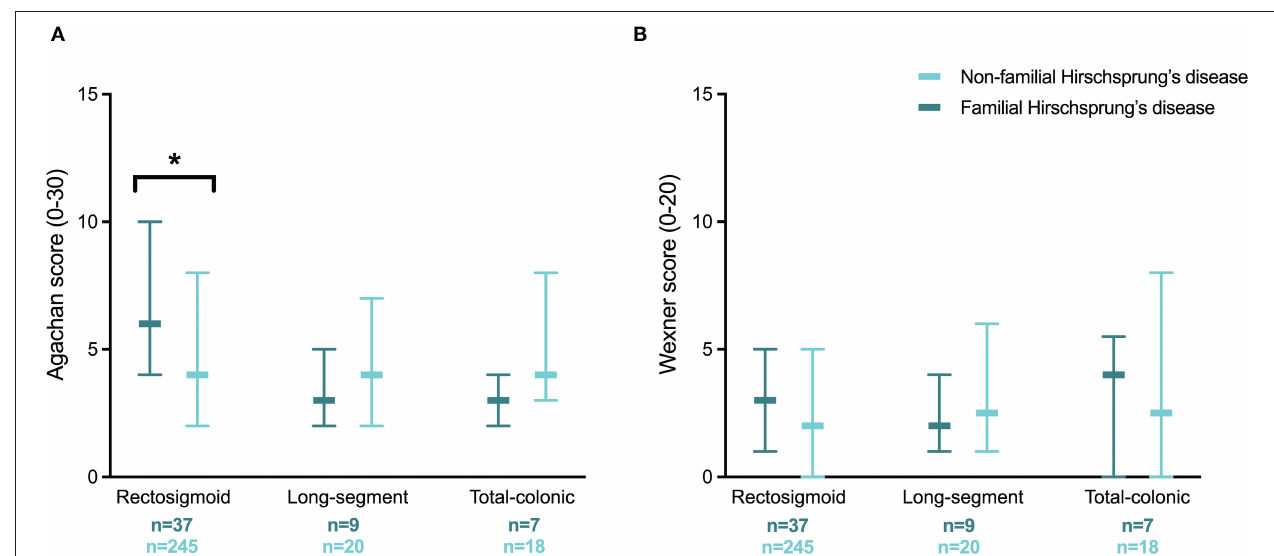
FIGURE 3 | Severity of constipation (A) and fecal incontinence (B) in patients with familial and non-familial Hirschsprung’s disease for different categories of aganglionic length. Values are reported as medians with interquartile ranges. *Statistical significance of p < 0.05.